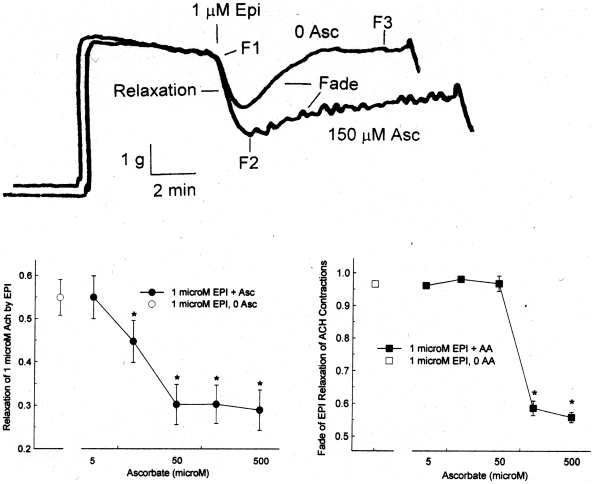
Effect of ascorbate on 1 µM epinephrine relaxation of 1 µM acetylcholine contractions of porcine trachealis.Upper panel: chart records of individual contractions with 0 and 150 µM Asc. F1 is the 5 minute Ach force, at which time Epi is added. F2 is the initial relaxation produced by Epi. F3 is the steady state force after the fade of the Epi relaxation. Middle Panel: Effect of ascorbate on initial epinephrine relaxation. Values are mean ± SE. The open symbol is 0 Asc; the filled symbols are 5–500 µM Asc. Note the log scale for the x axis. The * indicates a significant difference (p<0.05) from the 0 Asc relaxation. Lower Panel: Effect of ascorbate on the fade of the epinephrine-induced relaxation. Values are mean ± SE. The open symbol is 0 Asc; the filled symbols are 5–500 µM Asc. Note the log scale for the x axis The * indicates a significant difference (p<0.05) from the 0 Asc fade.